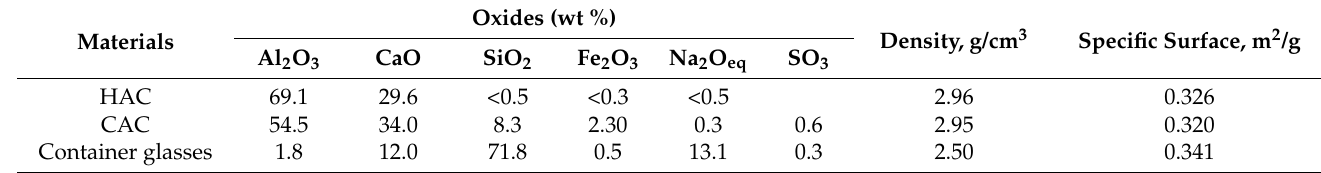
Table 2. The chemical composition and basic properties of cement types and container